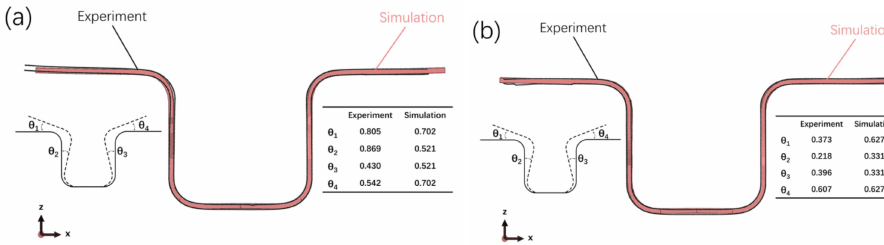
Figure 27. Comparison of the springback between numerical simulation of the U-shaped part and the blank used in the experiment. ( a ) TPP-S; ( b )